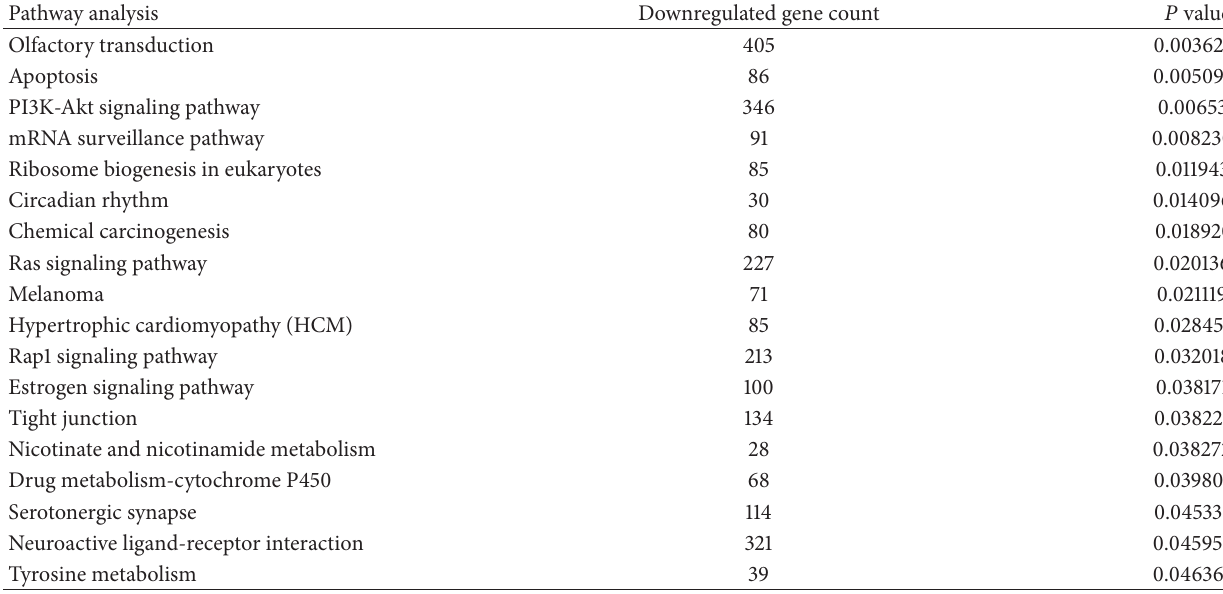
Table 3: Results of bioinformatics analyses on downregulated pathways in HUVECs after TGF 𝛽 1 (10ng/mL) stimulation.